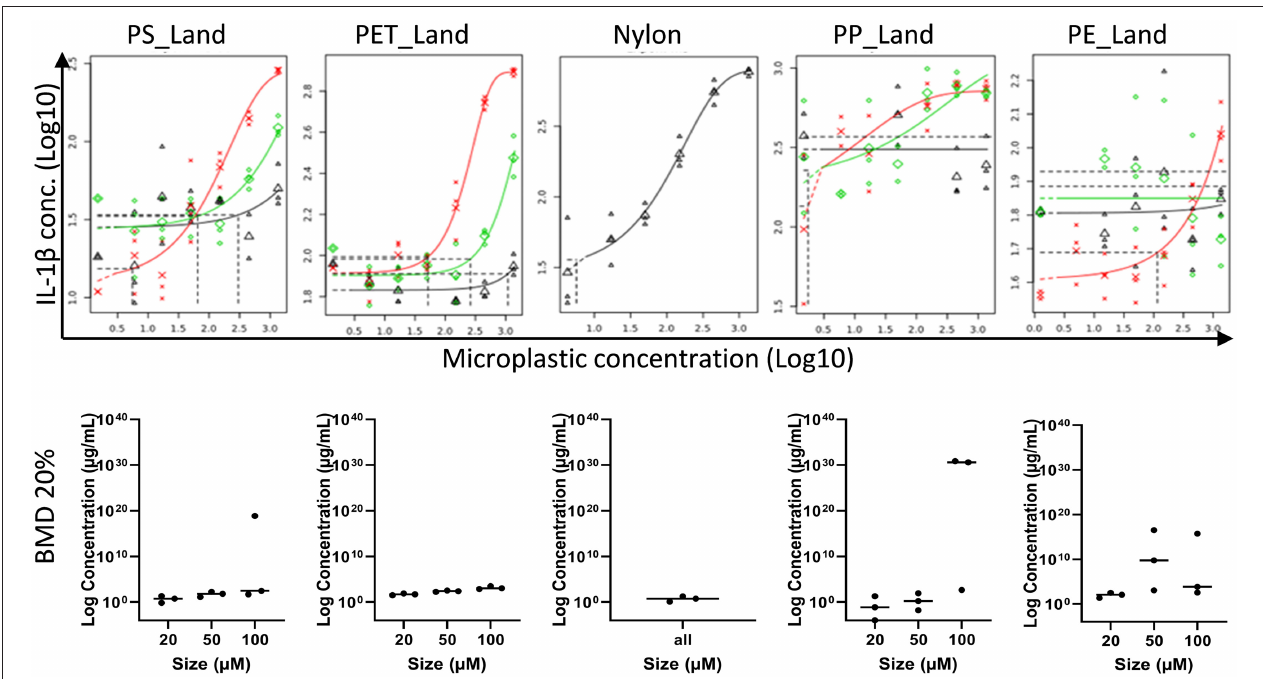
FIGURE 5 | Dose-response curves for IL-1 β . Top row are the PROAST analysis on effects of exposure to PS_Land, PET_Land, nylon, PP_Land, and PE_Land. The red, green and black curves represent the dose-response curves for exposure to 20–50 µ m, 50–100 µ m and 100–200 µ m respectively. For nylon only one size ( < 300 µ m) was investigated (black). The dotted vertical lines indicate the microplastic concentration at which cytokines are increased by 20% compared to non-exposed macrophages. Bottom row shows the BMD analysis on effects of exposure to again PS_Land, PET_Land, nylon, PP_Land, and PE_Land. Size fractions are given on the X-axis (20–50 µ m, 50–100 µ m and 100–200 µ m). BMD values are given on the Y-axis in log concentration, of which BMDL corresponds to the lowest dot, BMD the middle dot (vertical line), and BMDU the highest